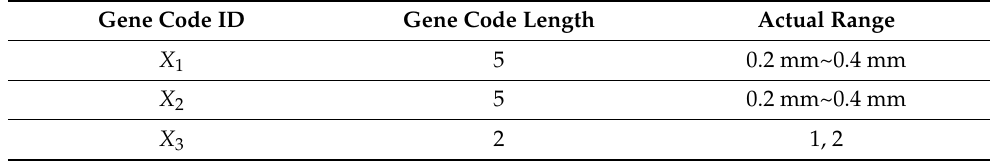
Table 3. Ranges of optimization